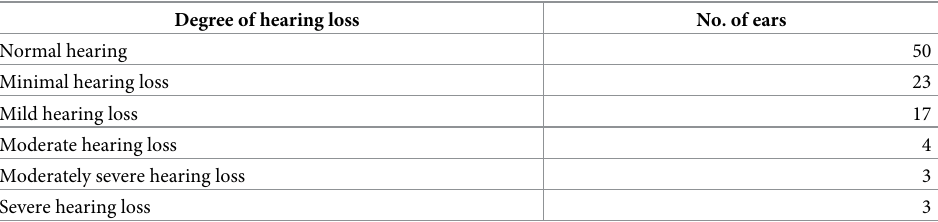
Table 2. Number of ears under each degree of hearing